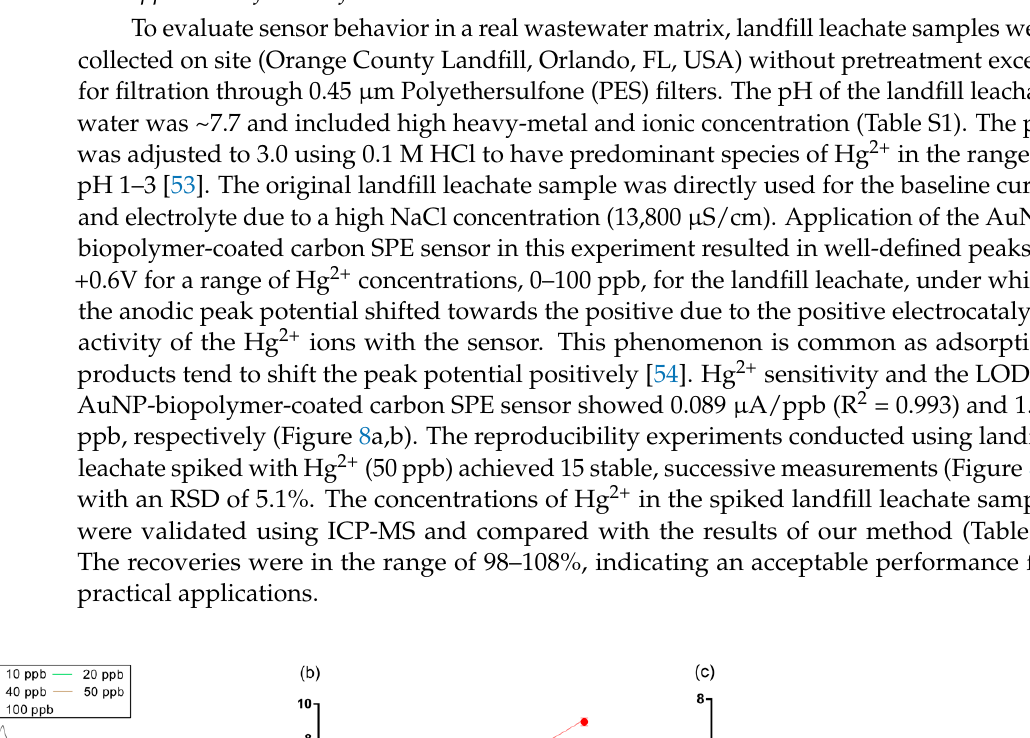
Figure 7. Sensor response changes at a fixed Hg 2+ concentration (20 ppb) in the presence of other metal ions (40 ppb) in 0.1 M AcB (pH 3.0). Mix indicates the solution containing Zn 2+ , Cd 2+ , Pb 2+ , and Cu 2+ (40 ppb) along with Hg 2+ (20 ppb). The error bars represent the standard deviation for the mean of the three replicate tests.